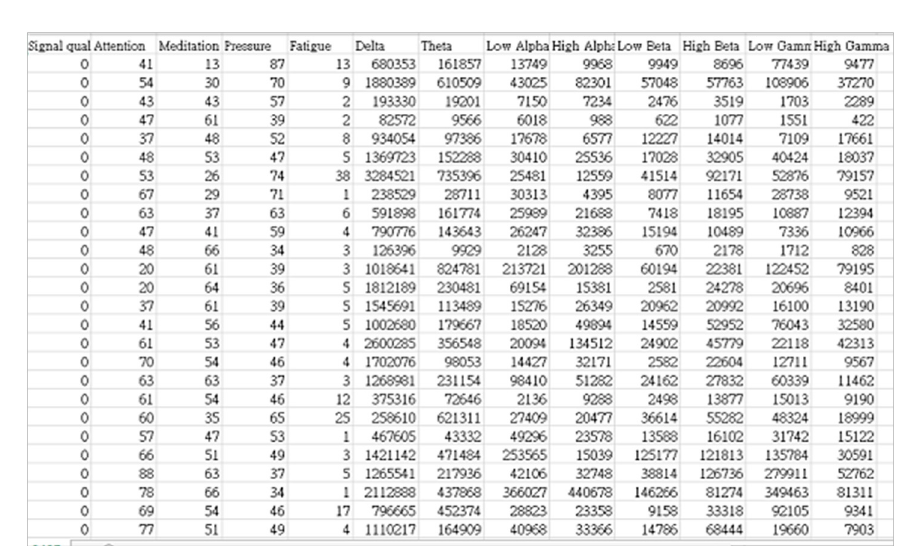
Figure 4. Screenshot of raw data in real-time EEG monitoring system. Table 3. Frequency range of EEG bands.